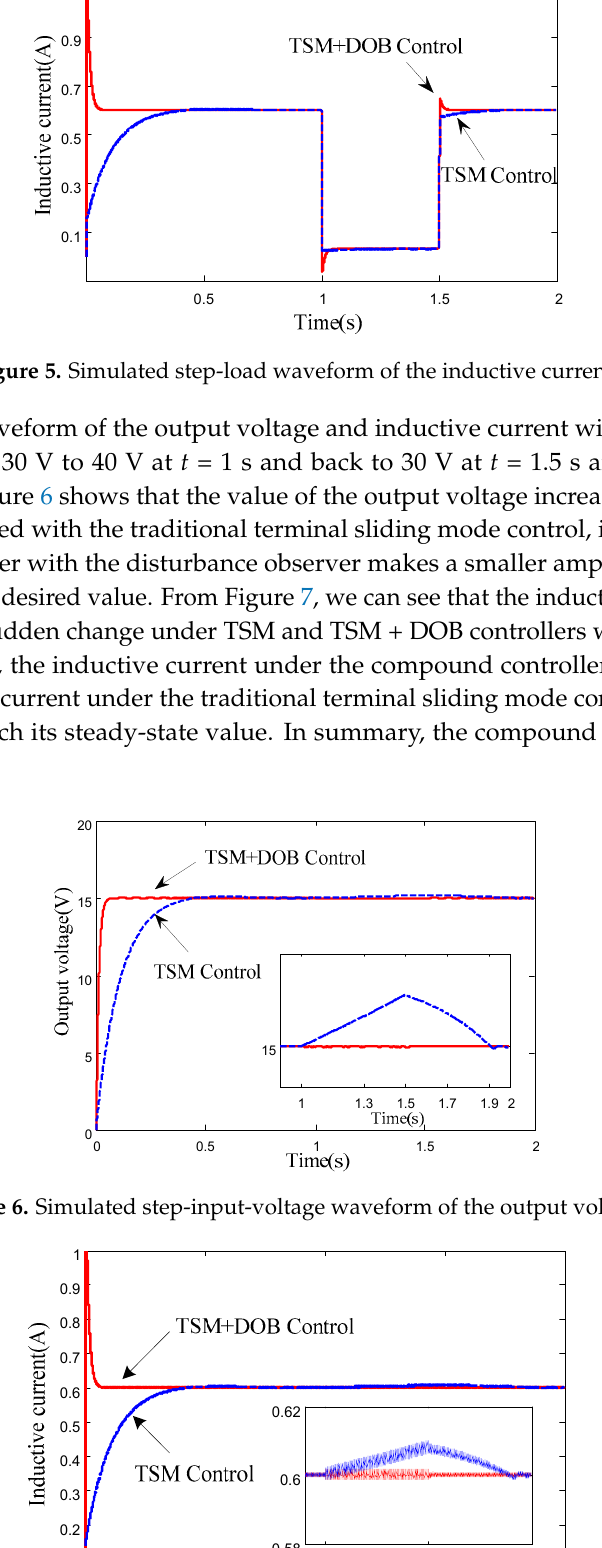
Figure 4. Simulated step ‐ load waveform of the output voltage.